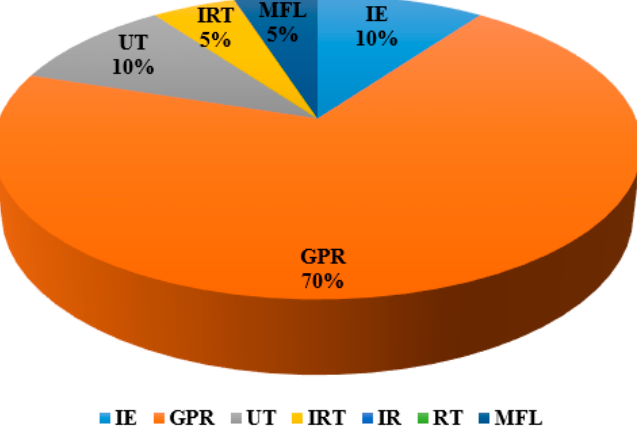
Figure 6. Statistical representation of NDT methods most applicable to detect delamination.